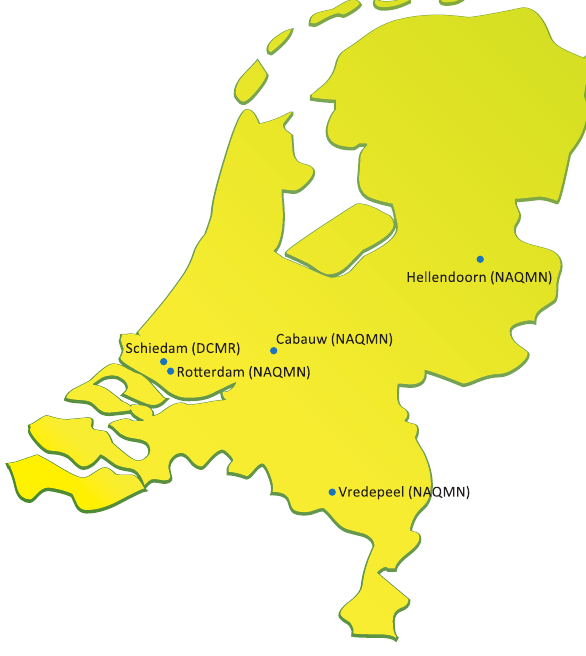
Fig. 1. Localisation of the five BOP measurement sites in the